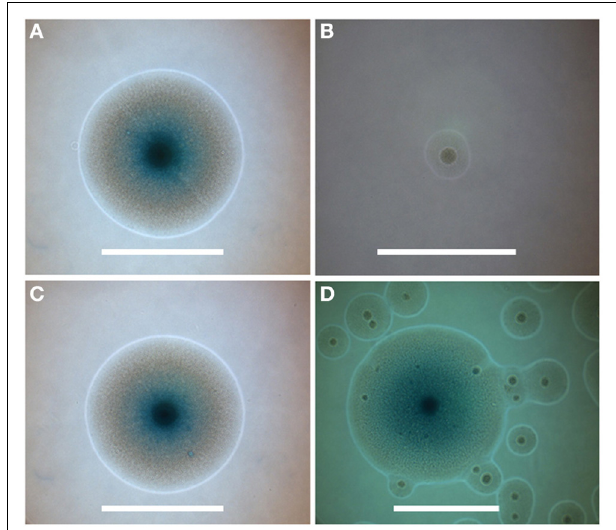
FIGURE 7 | Colony phenotypes associated with nusG deletion and rescue. (A–C) Individual colonies were photographed 72h after plating on agar medium from sparse fields where colony growth would be unaffected by neighboring colonies. Colonies represent (A) JCVI-syn1.0, (B)